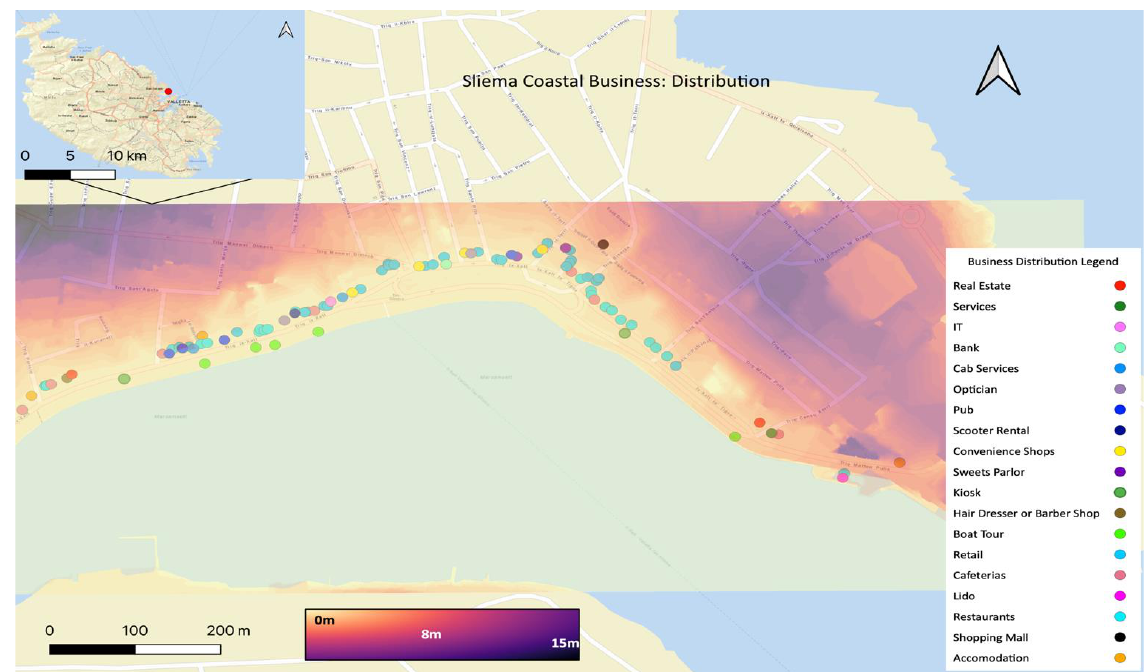
Figure 8. Sliema’s coastal businesses’ distribution.